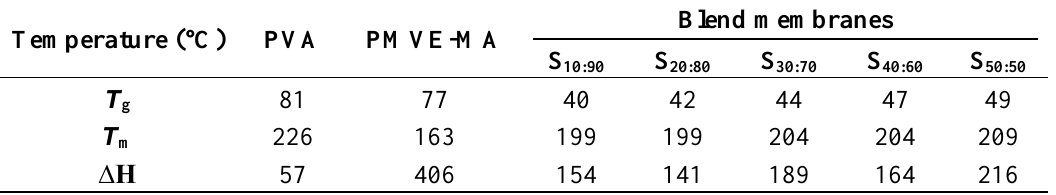
Table 3. DSC results of PVA and PMVE-MA